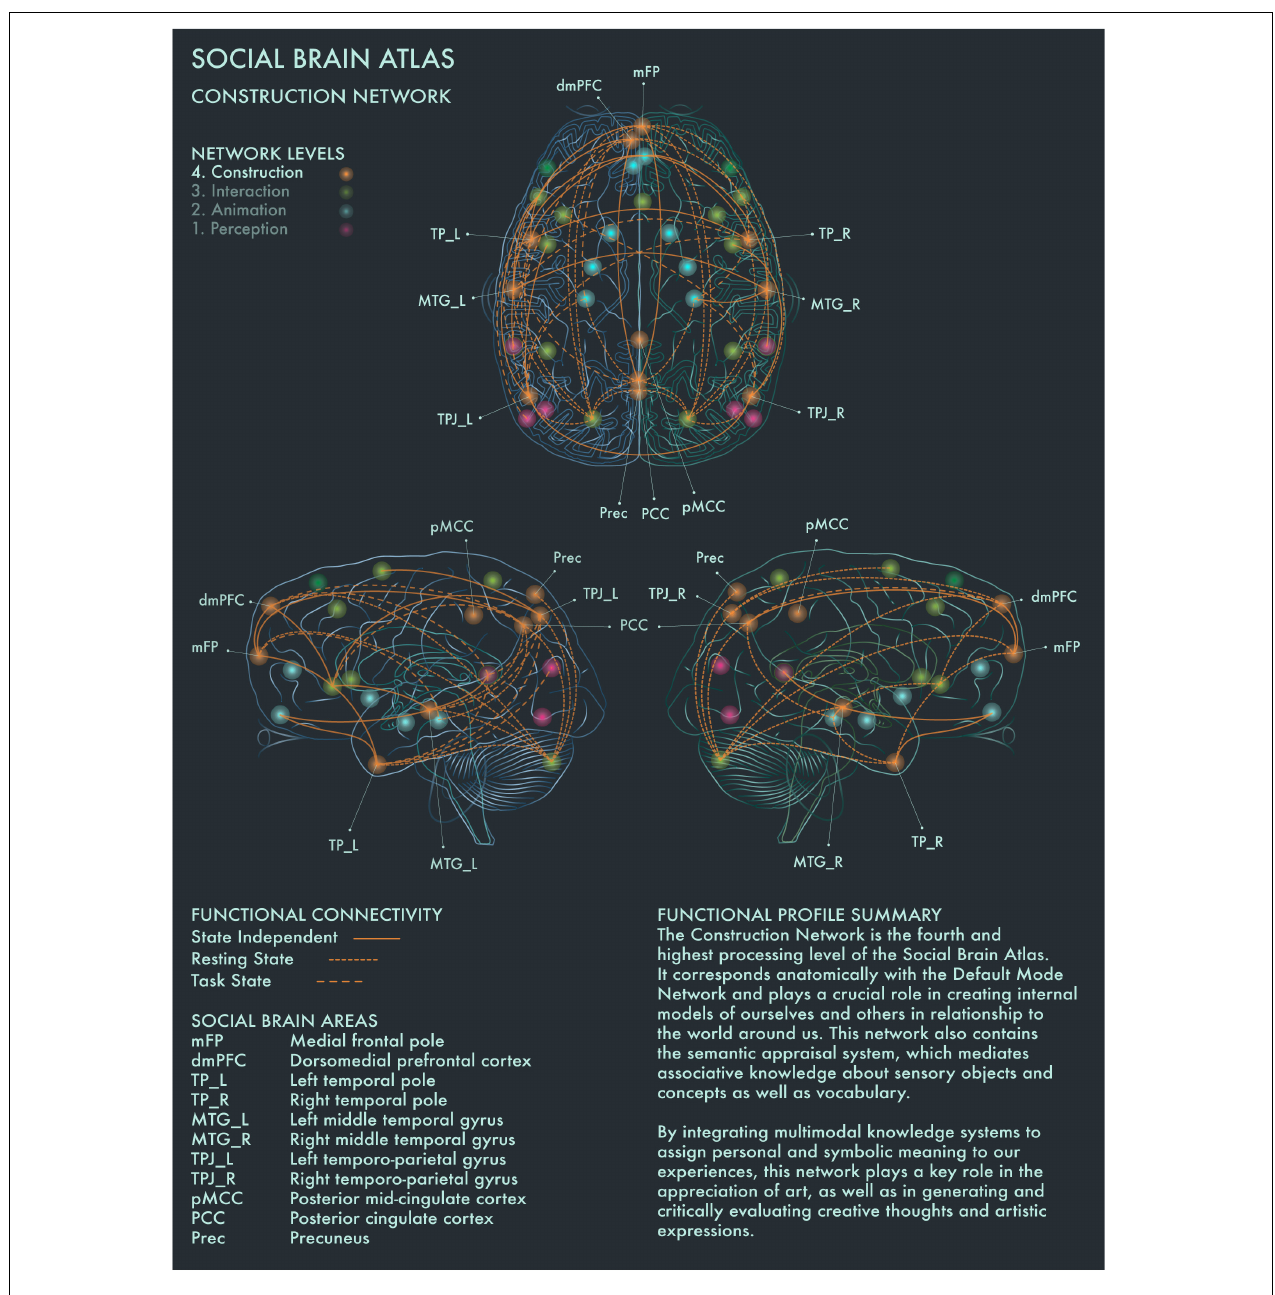
FIGURE 4 | Social Brain Atlas Level 4: Construction Network. This figure shows the functional connectivity patterns of the Construction Network (CN), based on data derived from Alcalá-López et al. (2017) (see also Table 1(D) ). Graphical conventions are the same as Figure 1 . The core nodes of the CN have been labeled as follows: Medial frontal pole (mFP); Dorsomedial prefrontal cortex (dmPFC); Bilateral temporal pole (TP_L/R); Bilateral middle temporal gyrus (MTG_L/R); Bilateral temporo-parietal junction (TPJ_L/R); Posterior mid-cingulate cortex (pMCC); Posterior Cingulate Cortex (PCC); Precuneus (Prec). The CN is the fourth and highest processing level of the social brain connectome. It corresponds anatomically with the Default Mode Network and plays a crucial role in creating internal models of ourselves and others in relationship to the world around us. This network also contains the semantic appraisal system, which mediates associative knowledge about sensory objects and concepts as well as vocabulary. By integrating multimodal knowledge systems to assign personal and symbolic meaning to our experiences, the CN has a key role in the appreciation of art, as well as in generating and critically evaluating creative thoughts and artistic